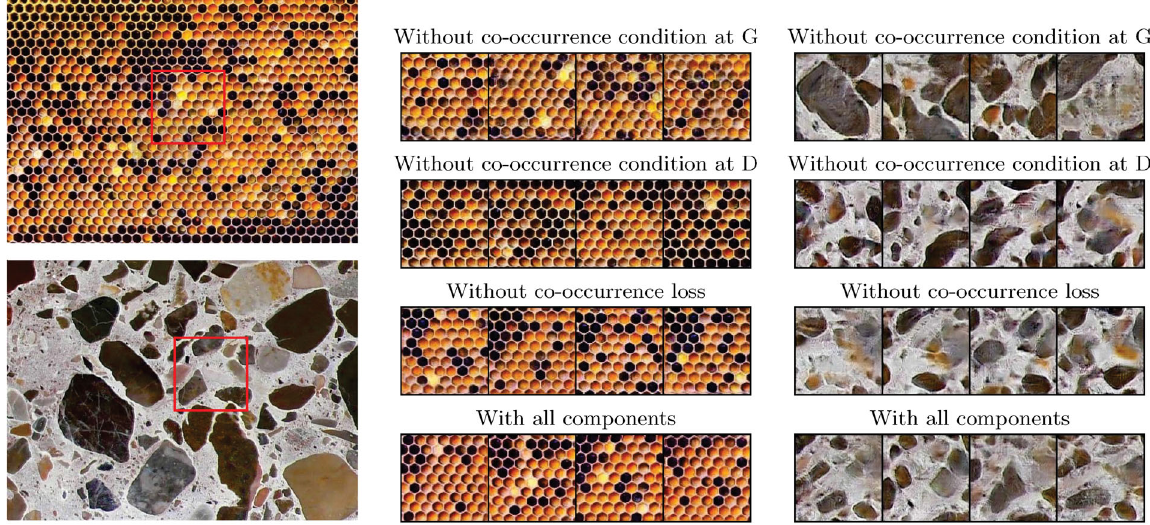
Fig. 11 Ablation study. Each row on the center and right shows several synthesized texture samples, conditioned on the co-occurrence of the reference crop, marked on the texture exemplars on the left. Each time one component of our method is turned off. G and D stand for Generator and Discriminator, respectively. When one of the components is missing, the fidelity to the input co-occurrence is compromised. When all the components are used, the generated samples better respect the properties of the reference